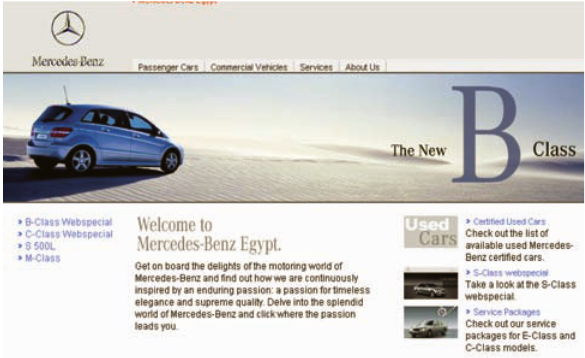
Fig 7. Mercedes-Benz Egypt: Selling a passionate experience